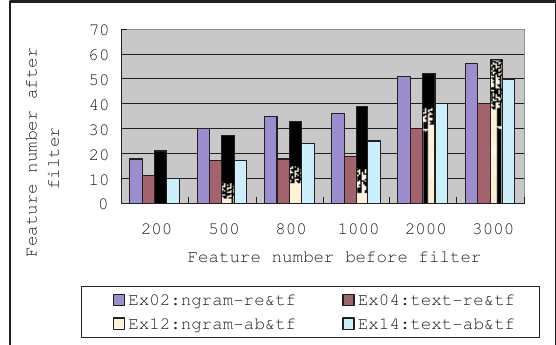
Fig. 3. Comparison on matrix sparseness.